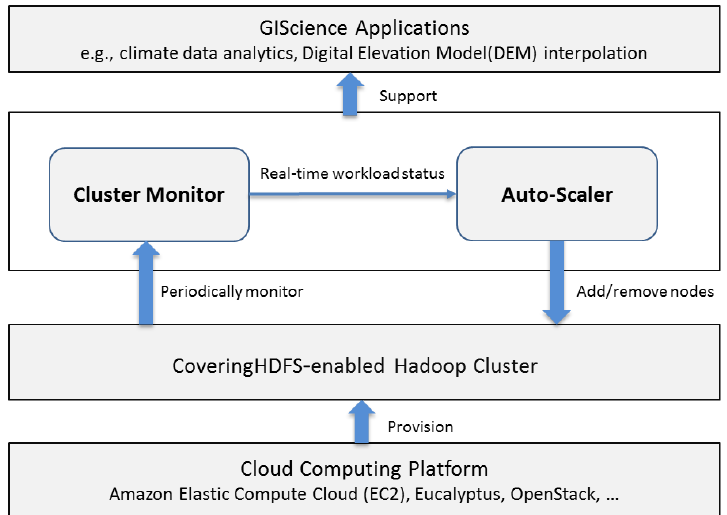
Figure 1. Auto-scaling framework.